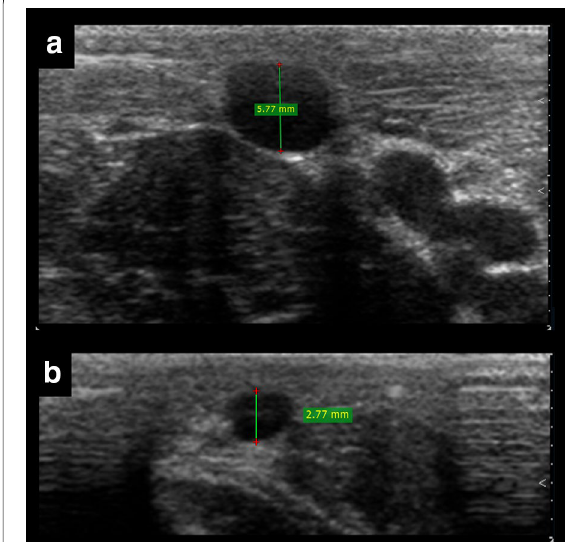
Fig. 4 Two different anteroposterior diameters of the vein for US-guided cannulation. The vein in a has an excellent diameter for cannulation (> 4 mm), in contrast with the smaller vein in